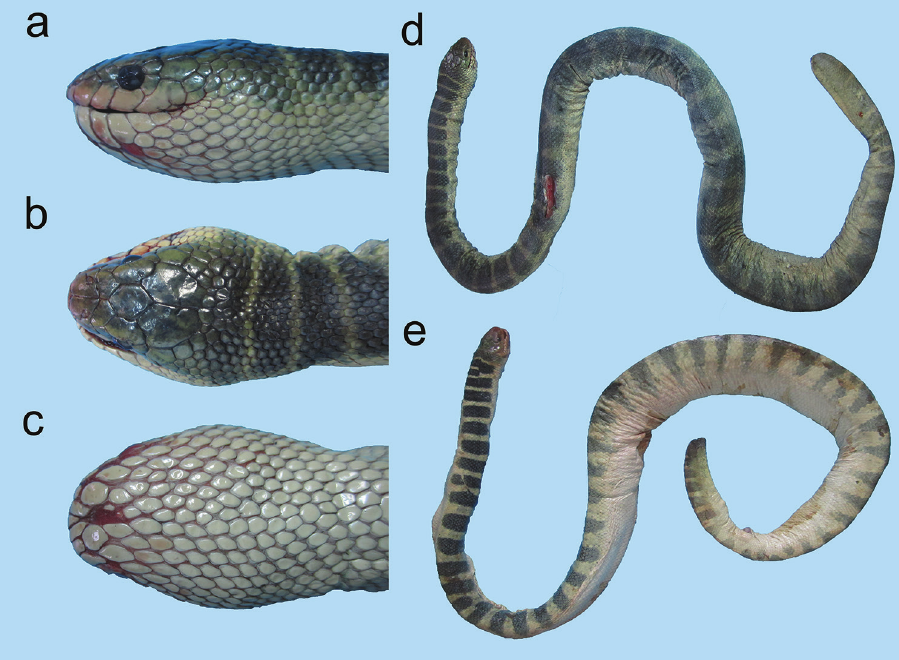
Figure 17. Hydrophis ornatus : a lateral view b dorsal view, and c ventral view of head d gray body e dirty white